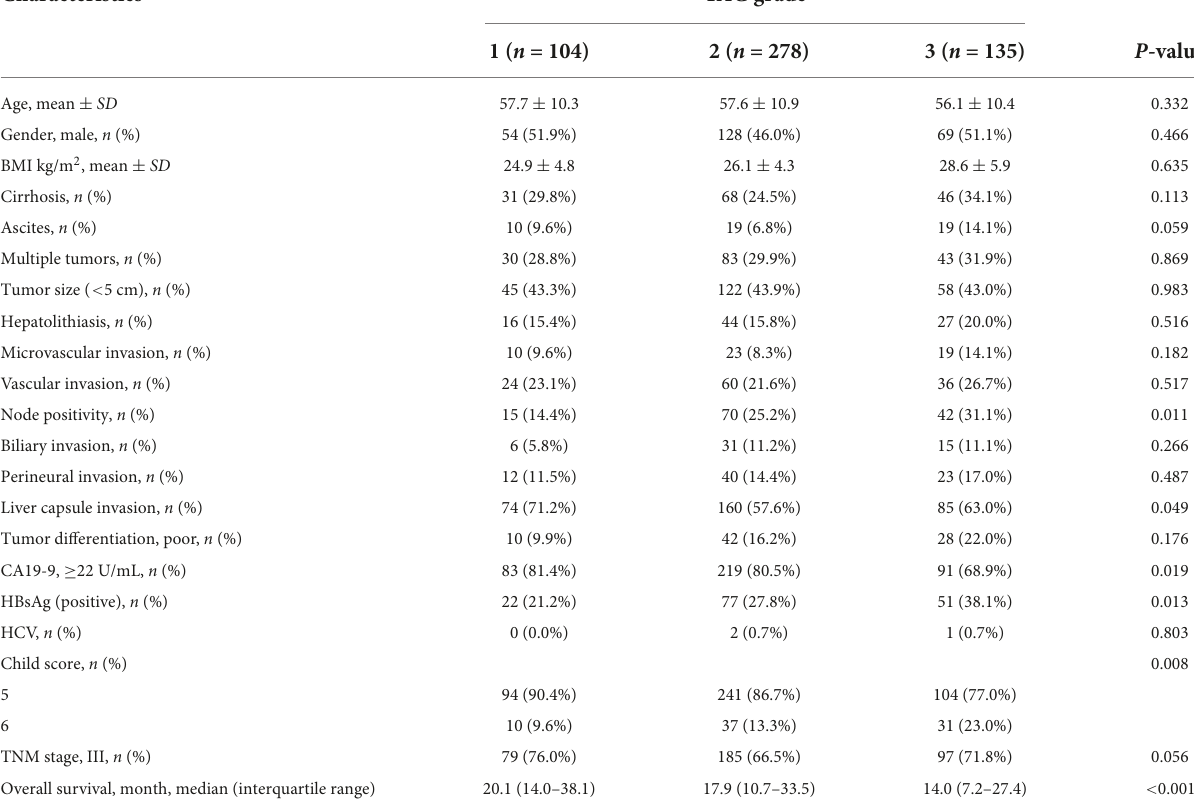
TABLE 5 Comparison of characteristics with the different TAG grades of 517 ICC patients treated with surgical resection in the discovery set.